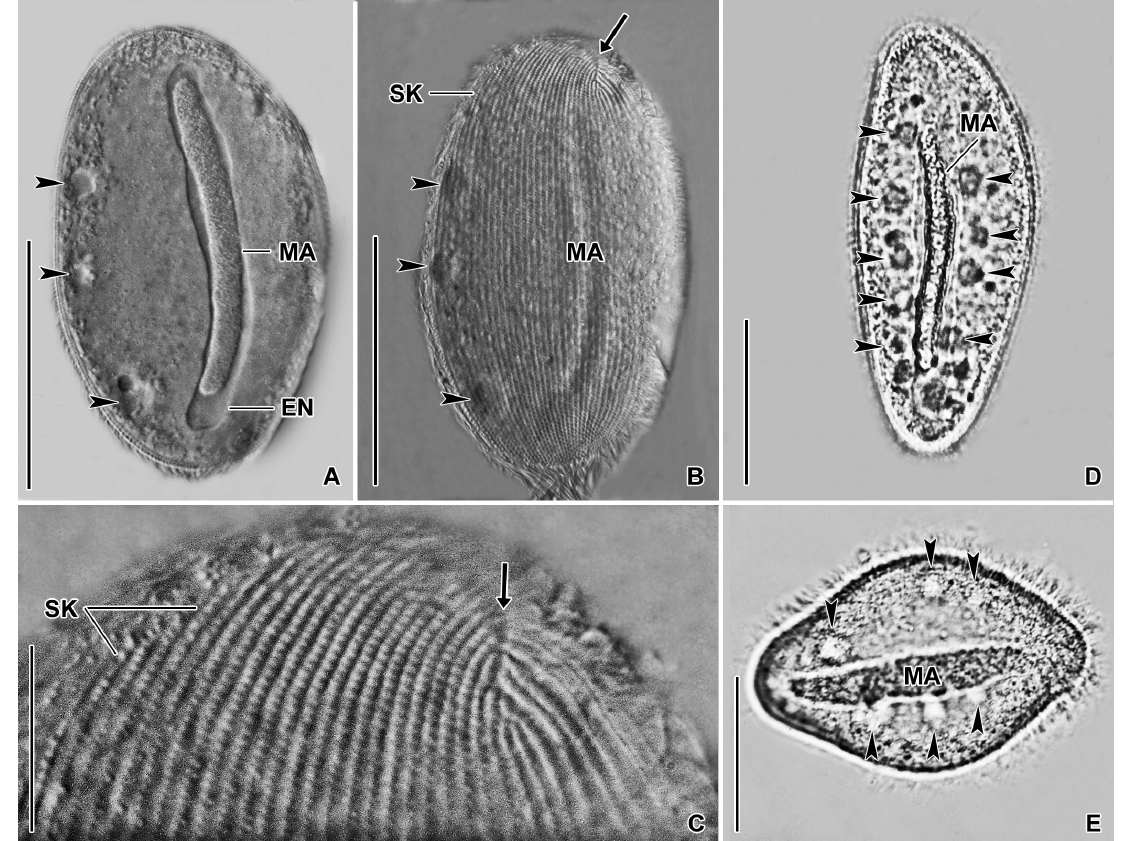
Fig. 11. Anoplophrya vulgaris de Puytorac, 1954 (A‒C) and Anoplophrya nodulata (Dujardin, 1841) (D–E), Slovak specimens in vivo . A–B . Ventral views, showing the nuclear apparatus, the arrangement of contractile vacuoles (arrowheads) and the somatic ciliary pattern. Arrow marks the apical suture. C . Detail of the anterior body region, showing the apical suture (arrow) and the meridional ciliary rows composed of very narrowly arranged basal bodies. D–E . Optical sections, showing the general body organization. The body is ovate to broadly fusiform with both ends rounded. The macronucleus is rod- like with slightly irregular surface. There are two rows of contractile vacuoles (arrowheads). Scale bars: A–B, D–E = 50 µm; C = 20